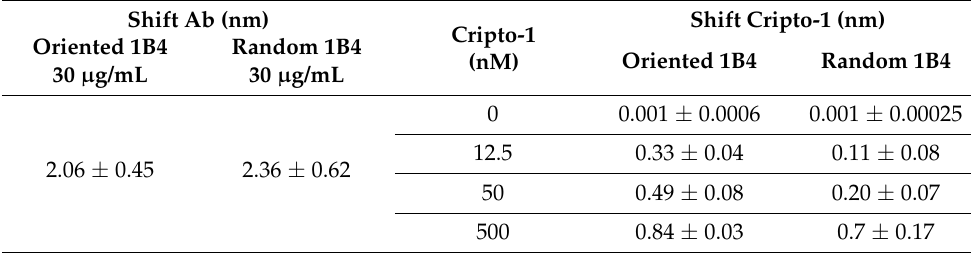
Figure 7. Normalized interferograms obtained for Cripto-1 detection at different concentrations (12.5–50–500 nM) by 1B4 immobilized in oriented ( a ) and random ( b ) configurations. Table 2. Normalized BLI shift values (nm) measured during Cripto-1 detection at different con- centrations (12.5–50–500 nM) by oriented 1B4 and random 1B4. Each point is the mean of three different